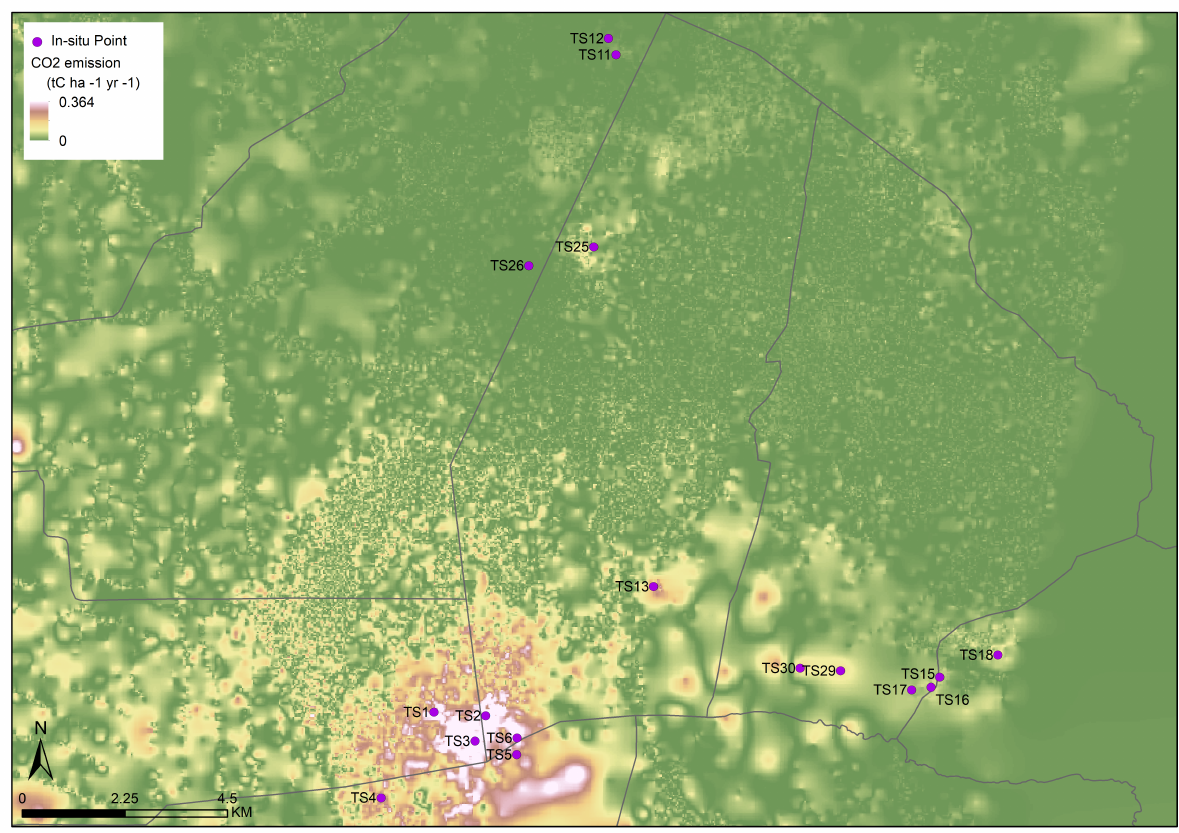
Figure 8. A map of CO2 emission in Banjar Regency and Banjarbaru City, South Kalimantan, Indonesia estimated by the in-situ measurement and satellite remote